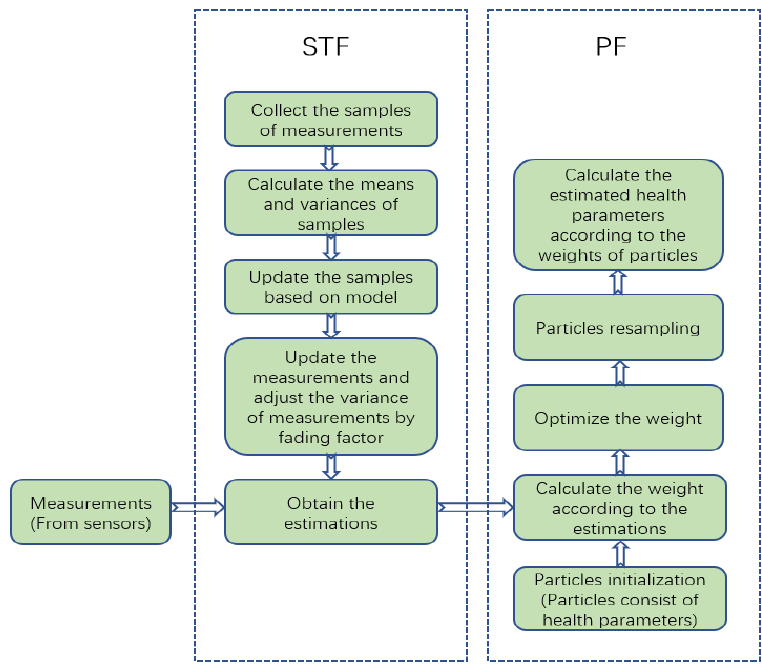
Figure 1. Principle of hybrid filter.